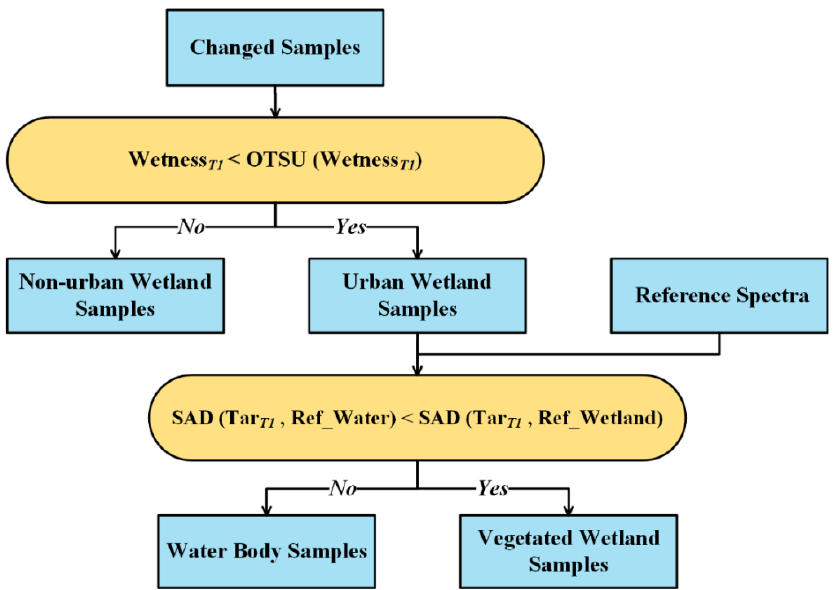
Figure 5. The decision tree for the classification of the changed samples. 𝑇1 is the target year; 𝑊𝑒𝑡𝑛𝑒𝑠𝑠 𝑇1 is the wetness feature of the image. 𝑇𝐴𝑅 𝑇1 represent spectra values measured at time 𝑇1 , 𝑅𝑒𝑓_𝑊𝑎𝑡𝑒𝑟 and 𝑅𝑒𝑓_𝑊𝑒𝑡𝑙𝑎𝑛𝑑 are the reference spectra of the water body and the vegetated wetland, respectively.